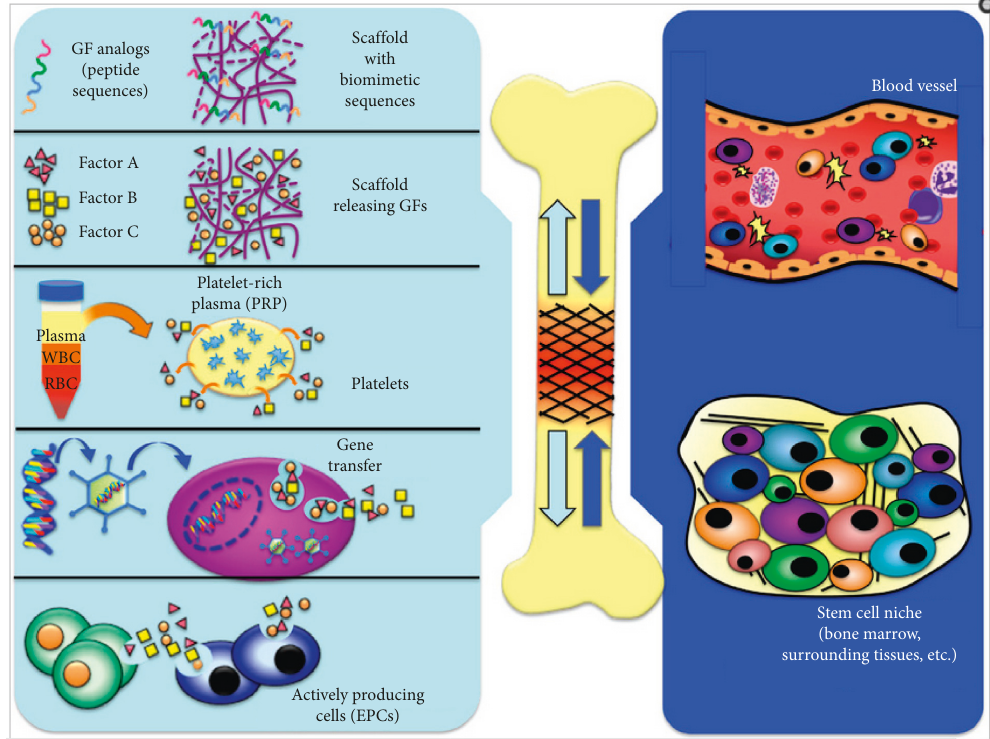
Figure 5: Schematic illustration of the bone tissue engineering